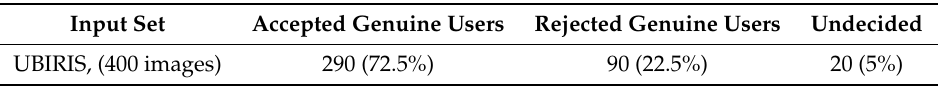
Table 5. Iris recognition acceptance rates for genuine